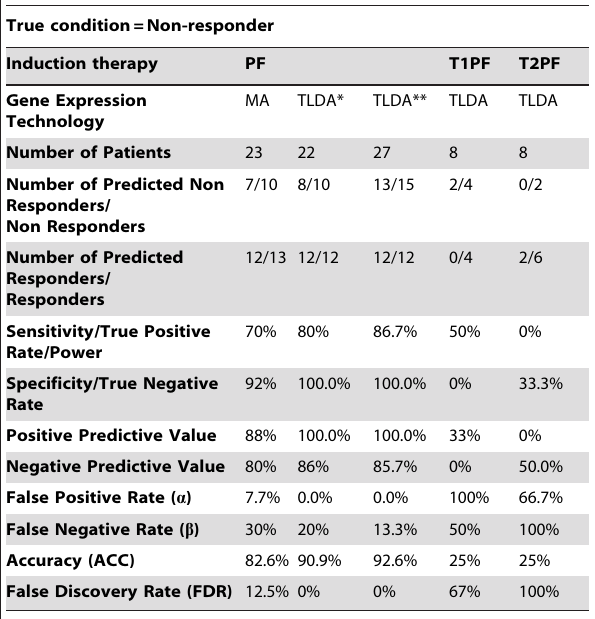
Table 5. Statistical Summary for 10 Gene